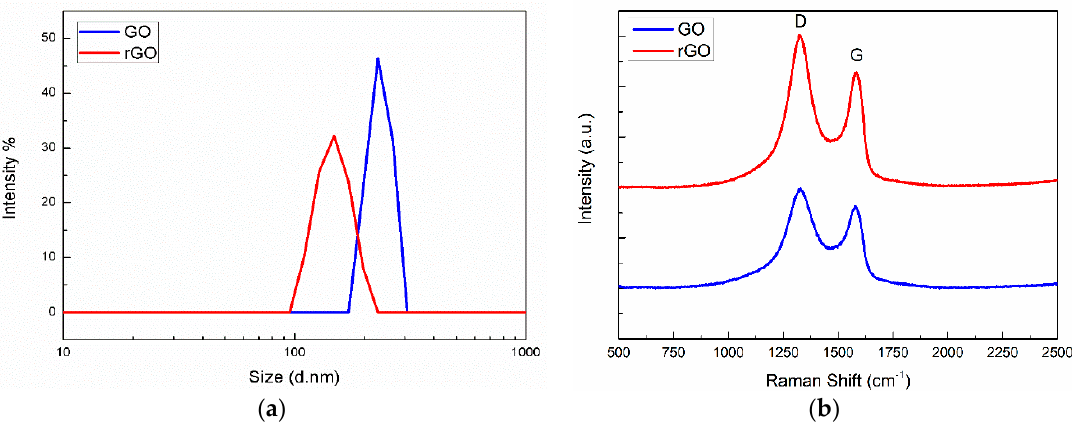
Figure 3. GO and rGO; ( a ) Dynamic Light Scattering (DLS) analysis of dispersion; ( b ) Raman spectra.